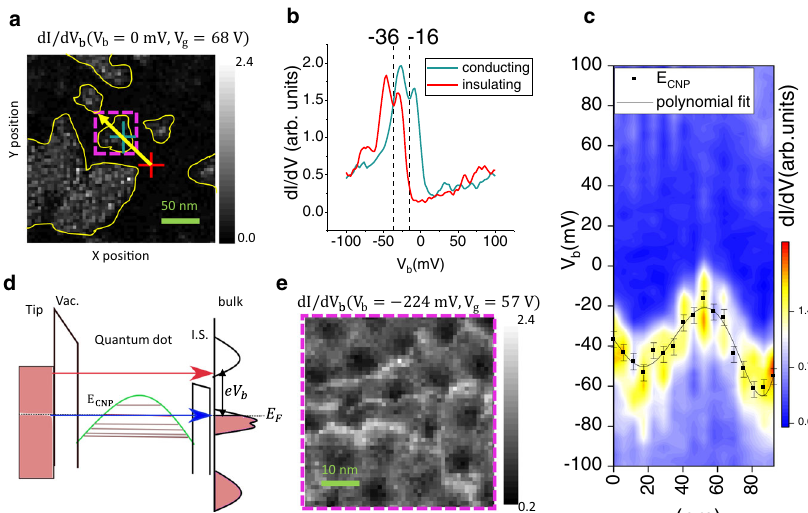
(cid:7) (cid:8) spatial map of a 246 × 246 nm 2 region (scale bar Fig. 3 Evidence of local doping variation in the sample. a Shows a dI = dV b x ; y ; V b ¼ 0 mV ; V g ¼ 68 V 50 nm). Several bright regions, indicating a high density of states, which are surrounded by dark regions, indicating a low density of states are visible. The thin yellow lines are a guide for the eyes. b Shows individual dI = dV b spectra measured at the positions marked by the red and green crosses in a . A lateral shift of the two spectra with respect to the E F indicates a difference in the local chemical potential. The approximate location of the charge neutrality point taken as the dip between the two VHS is also labeled. c is a line-cut across the conducting island in a in a direction indicated by the yellow arrow. The variation of the local charge neutrality point energy ( E CNP ) as a function of position can be seen which indicates local doping variation. The black line is a 5th order polynomial fi t. Error bars represent uncertainty in the determination of CNP due to fi nite energy resolution. The bright conducting regions surrounded by the darker insulating regions act like quantum dots. d A tunneling diagram of the system. There are two tunneling barriers: the large vacuum barrier between the tip and the dot and the shorter barrier between the dot and the bulk of the sample. The quantum dot is de fi ned by a potential well which has the shape indicated by the local charge neutrality point. Con fi ned states within this potential well are indicated by horizontal lines. There are low- energy electron tunneling events from the tip into the con fi ned states of the quantum dot and then into the bulk of the sample (blue arrow). There also exist direct tunneling from the tip to the higher energy bands of the bulk of the sample (red arrow). e Shows a high resolution ð x ; y ; V ¼ (cid:1) 224 mV ; V ¼ 57 V Þ spatial map of the conducting island indicated by the magenta square in a . The three bright wavefronts are three dI = dV b b g